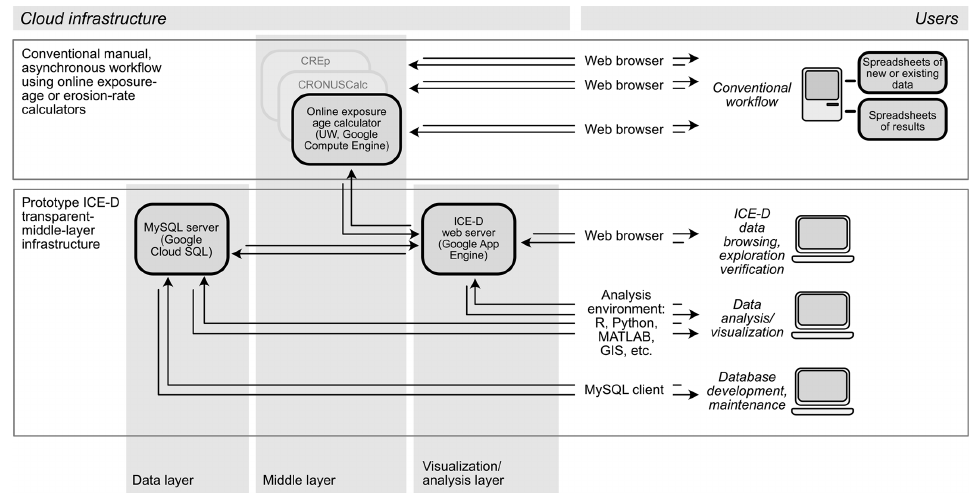
Figure 2. Generalized topology of the prototype ICE-D infrastructure compared to conventional manual, asynchronous use of online expo- sure age calculators. Cloud computing services interact to supply raw data, calculated exposure ages, and other derived products to users as needed for different levels of